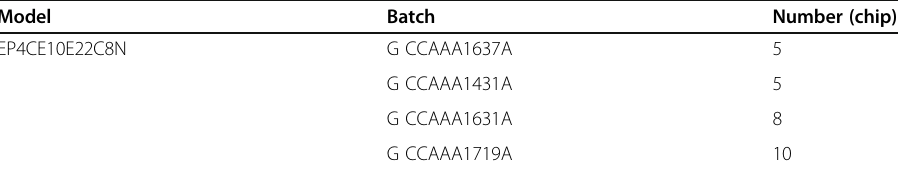
Table 1 Chip batch quantity details